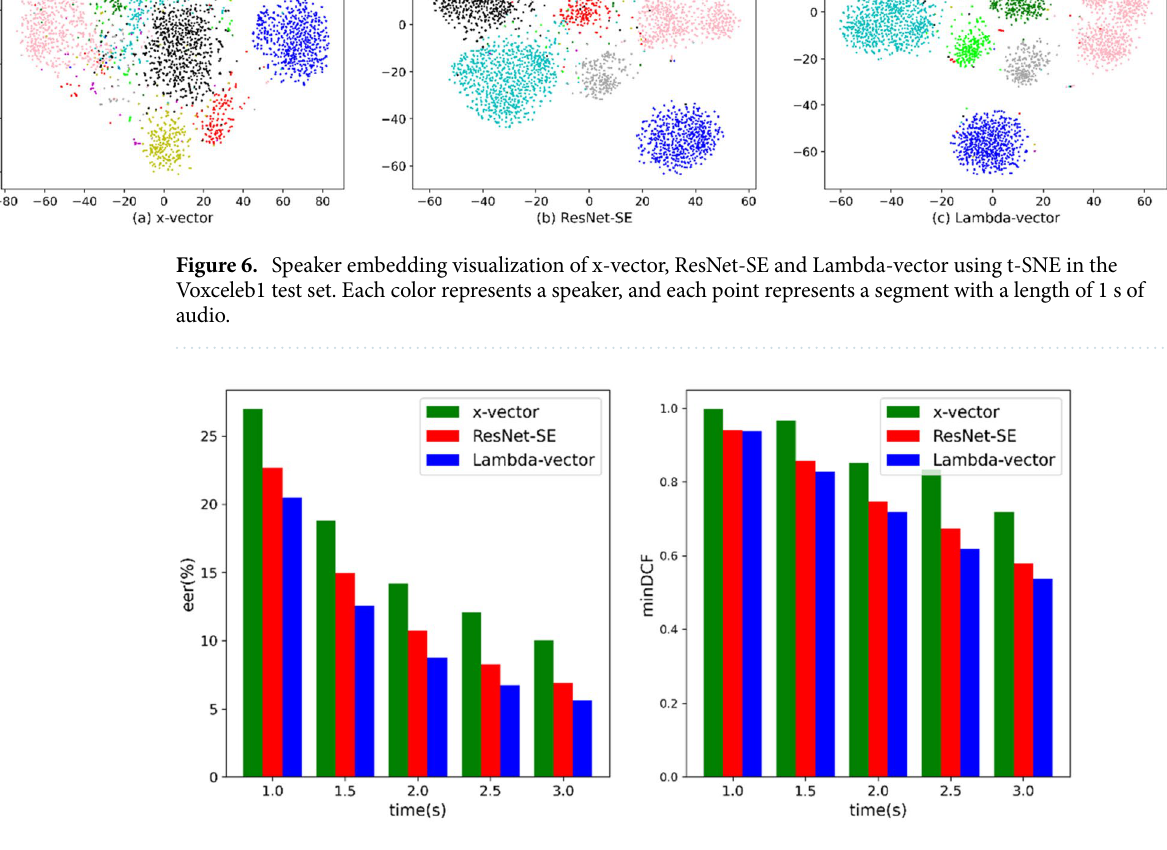
Figure 7. EER and minDCF on Voxceleb1 test set when the utterance length is 1 s, 1.5 s, 2 s, 2.5 s and 3